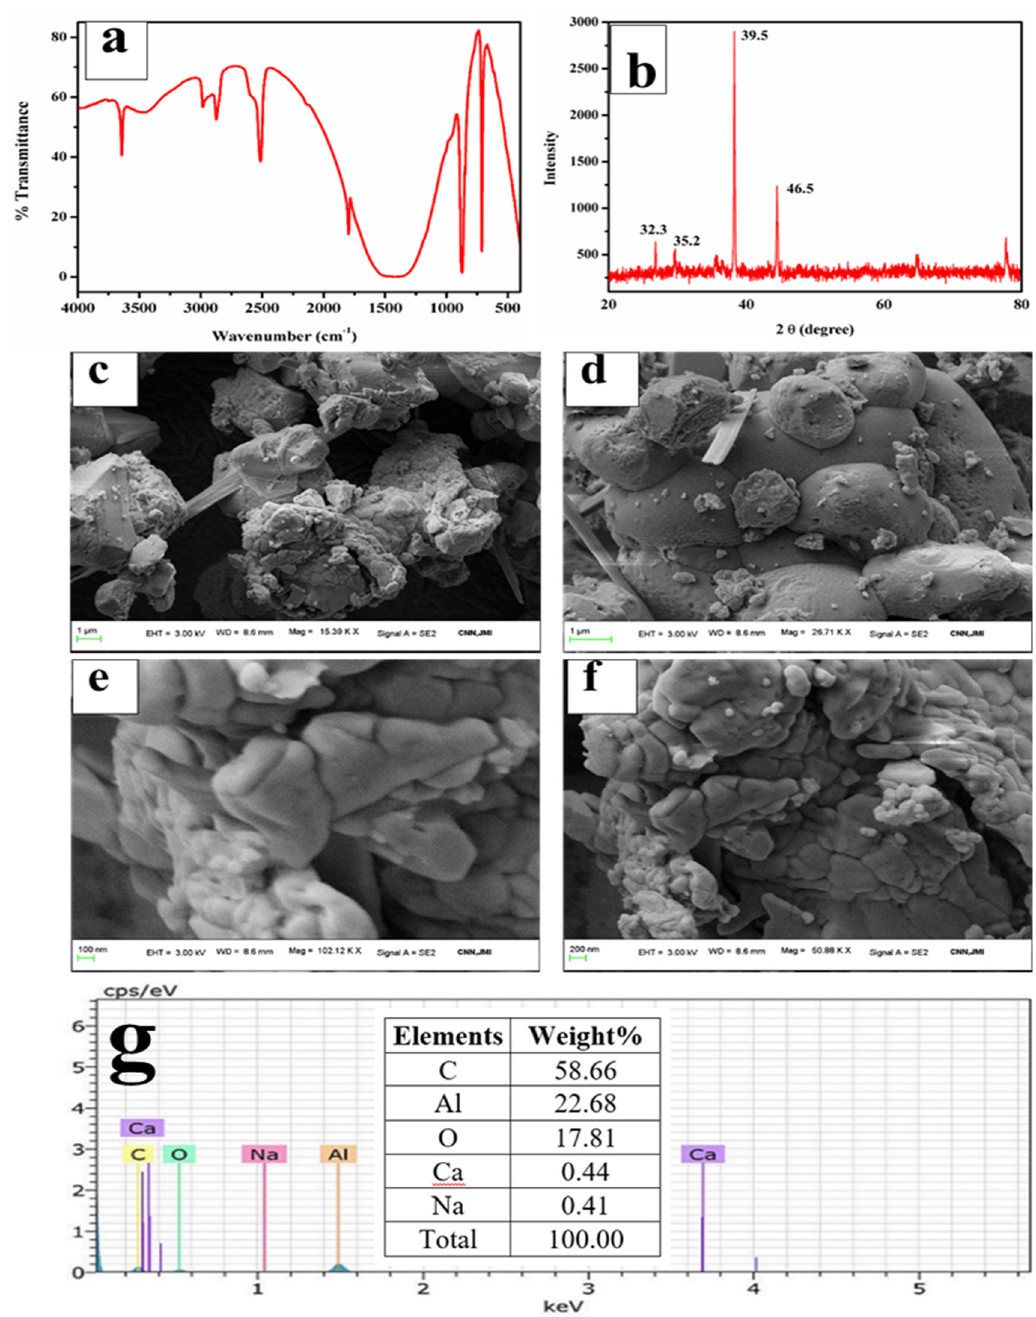
Figure 8. Analysis of alumina microparticles: ( a ) FTIR, ( b ) XRD, ( c – f ) FESEM micrographs, ( g ) EDS spectra.